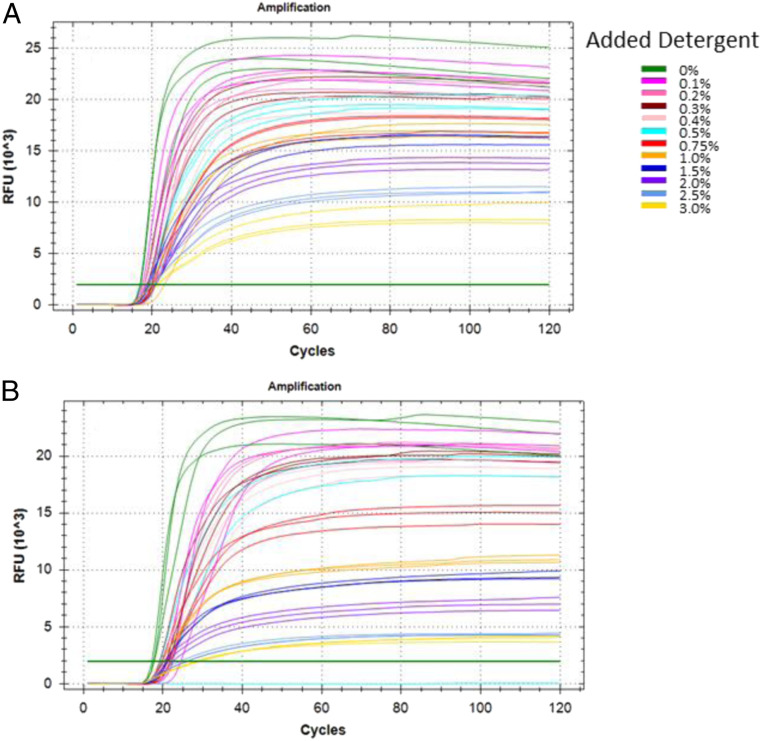
Assessment of RT-LAMP detergent tolerance. Fluorescent RT-LAMP reactions run for 120 30-s cycles at 65 °C. All reactions contain 500 control RNA copies, the Orf1a-HMS primer set, and 0 to 3% added (A) Tween20 or (B) TritonX100, as indicated.